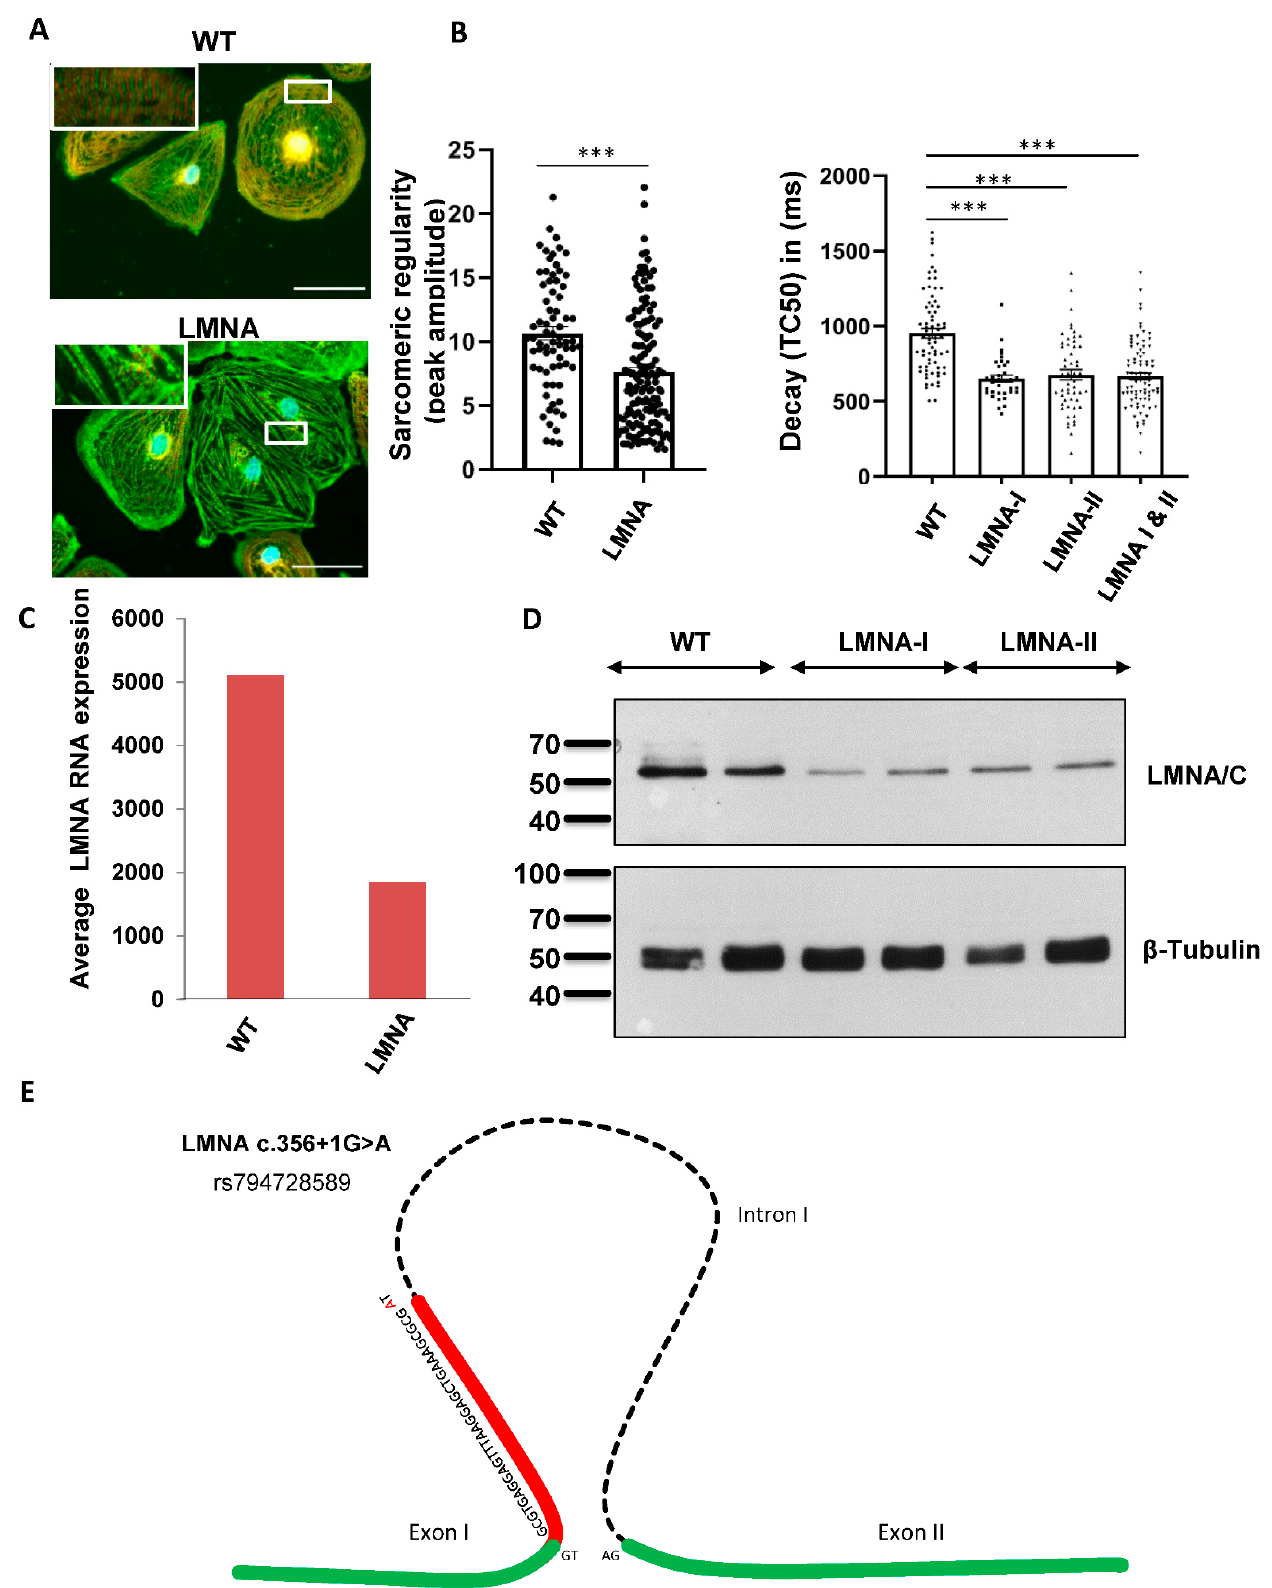
Figure 2. Identifying a novel LMNA variant using precise diagnostic methods. (A): Disturbed sarcomeric z-disc regularity in iPSC-CMs with the LMNA variant . The sarcomeric structure was visualized by immunofluorescent staining with α -actinin (green) and TTN-M8/M9 (red). Scale bar = 50 µm (white box). Using fast Fourier transformation (FFT), the sarcomeric pattern regularity of